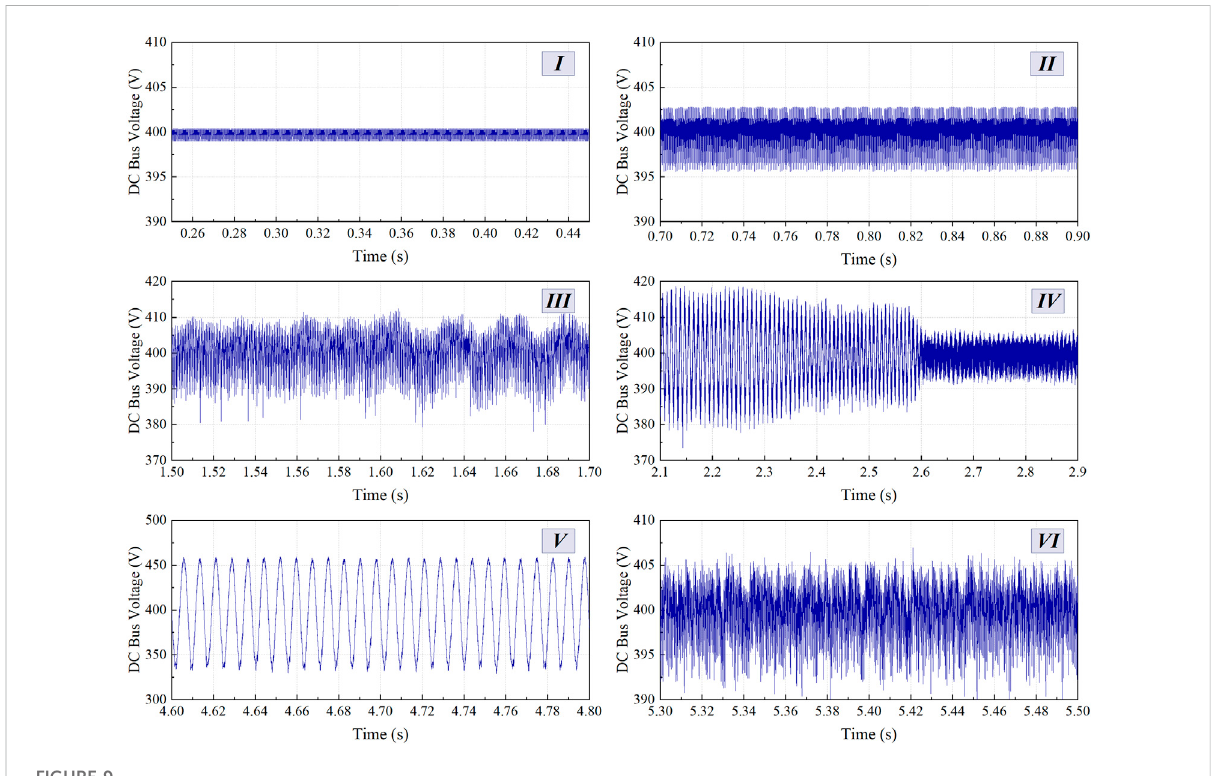
FIGURE 9 Zoomed dynamic of DC bus voltage during conditions